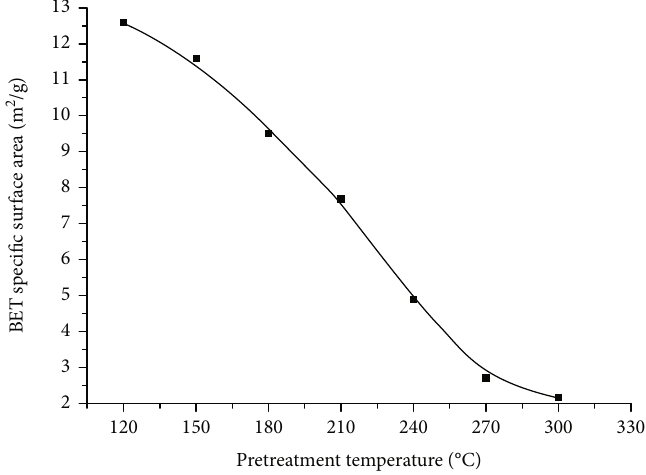
Figure 6: The dynamic change of total pore speci fi c surface area under various pretreatment